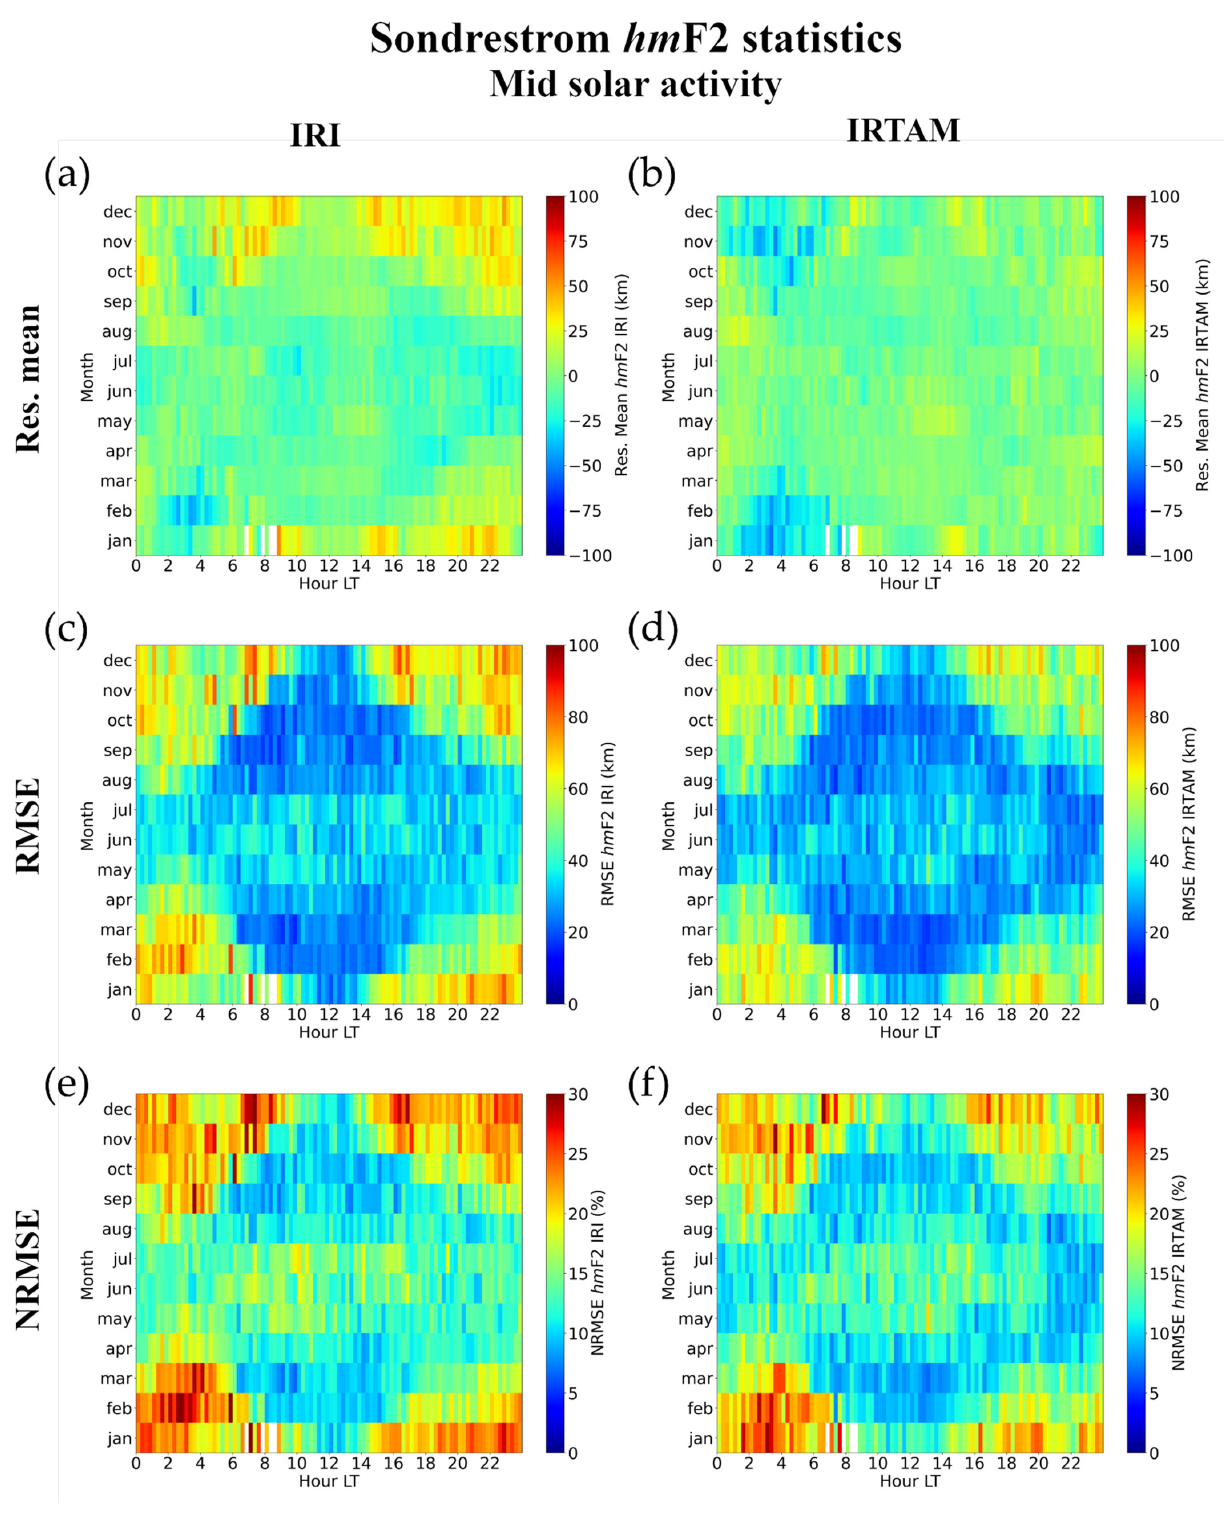
Figure 35. Same as Figure 34 but for MSA level.